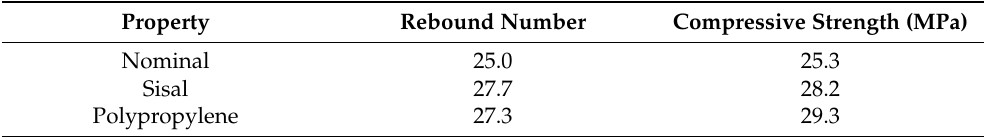
Table 5. Concrete Rebound and Compressive strength (MPa).